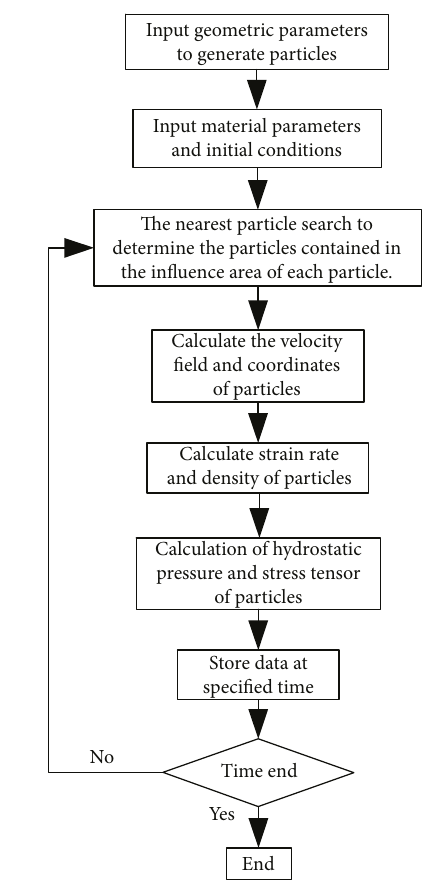
Figure 3: The calculation process of the SPH fi nite element